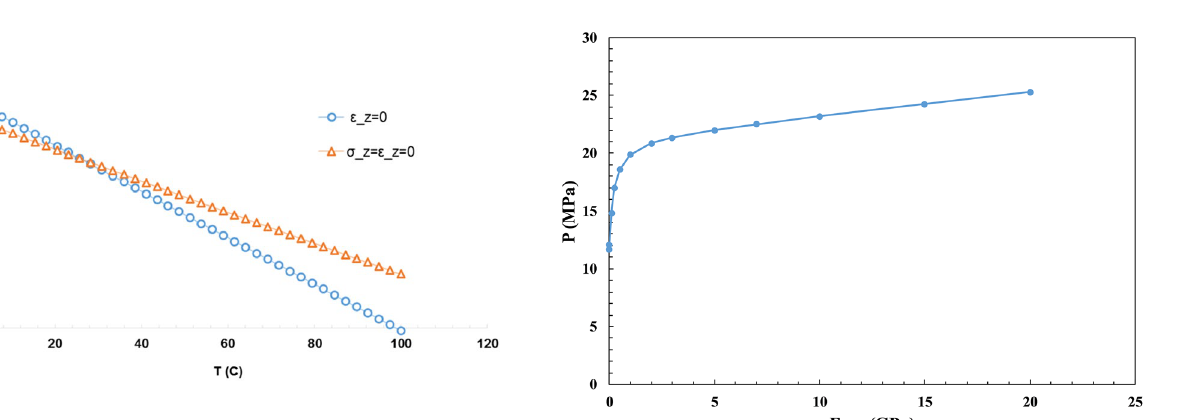
Fig. 16 The failure pressure versus the proportionality factor (α)